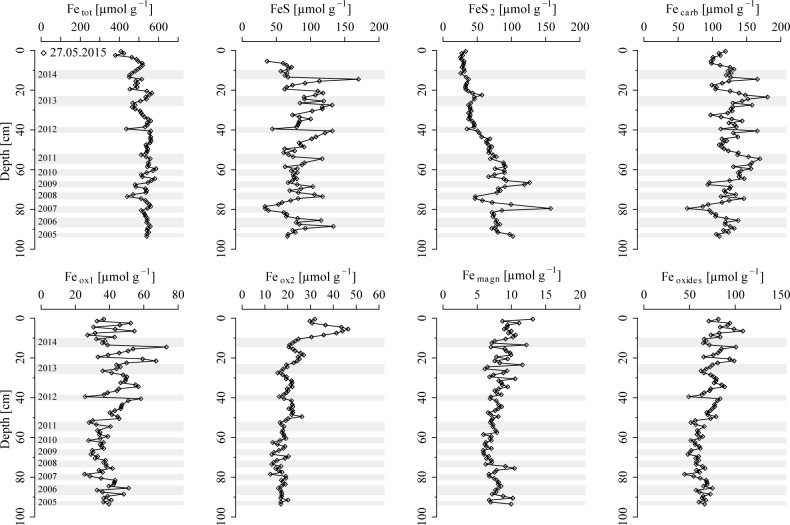
Fe extraction results including total sedimentary Fe (Fetot), acid volatile sulfide (FeS), chromium reducible sulfur (FeS2), carbonate associated Fe (Fecarb), easily reducible (amorphous) oxides (Feox1), reducible (crystalline) oxides (Feox2), recalcitrant oxides (mostly magnetite, Femagn) and total sedimentary Fe oxides (sum of Feox1, Feox2 and Femagn).Note that the total amount of Fe oxides may be overestimated due to dissolution of FeS in the hydroxylamine-HCl step (Feox1) [36]. Also note the different scales on the x axes. Grey bars correspond to sediments with elevated concentrations of solid phase Mo, indicative for anoxic bottom waters in the Scharendijke basin during summer.